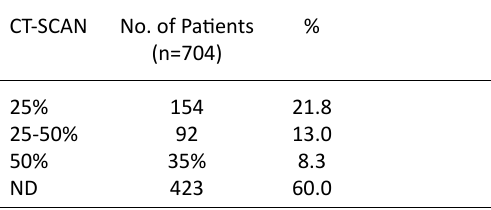
Table 3. Computerised Tomography scan of lung distribution in patients of COVID